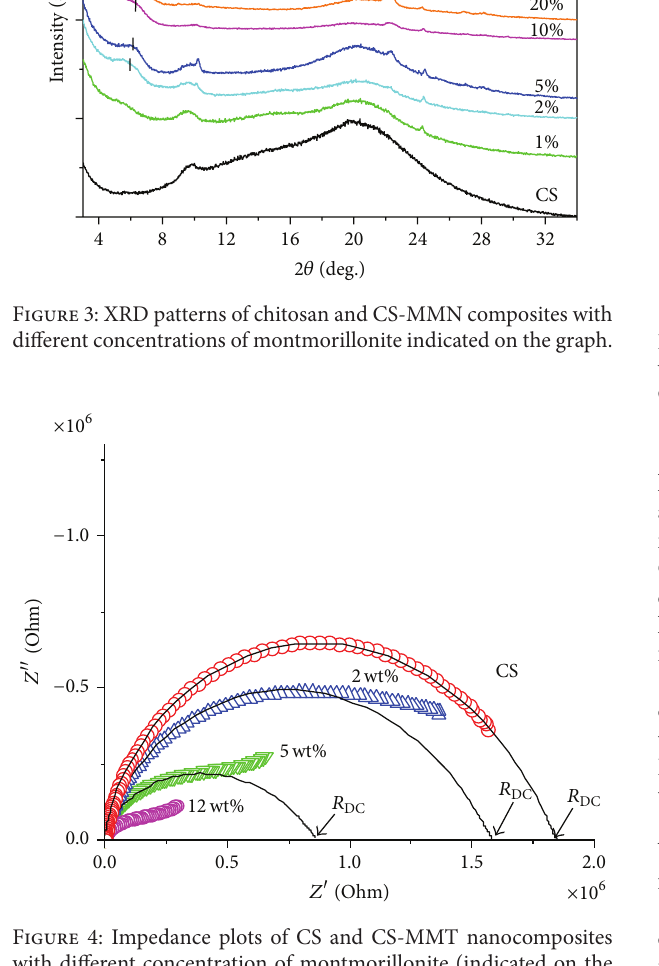
Figure 4: Impedance plots of CS and CS-MMT nanocomposites with different concentration of montmorillonite (indicated on the graph).